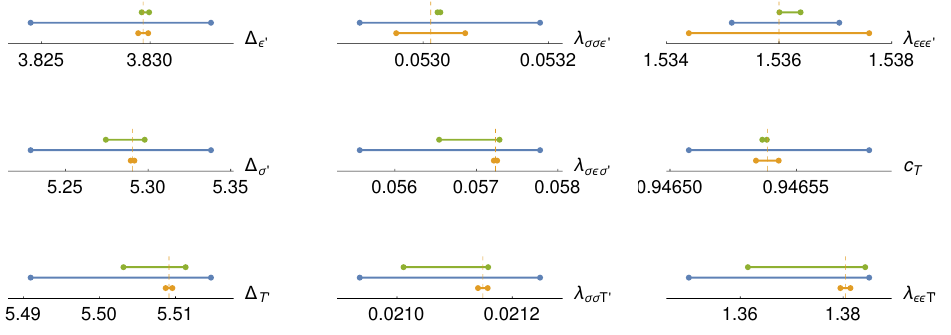
Figure 4 . In green: the allowed interval after fixing the first 4 parameters to be (∆ σ , ∆ (cid:15) , λ σσ(cid:15) , λ (cid:15)(cid:15)(cid:15) ) = (0 . 5181496671 , 1 . 412636636 , 1 . 05184946 , 1 . 53247348) . All allowed intervals shrink significantly